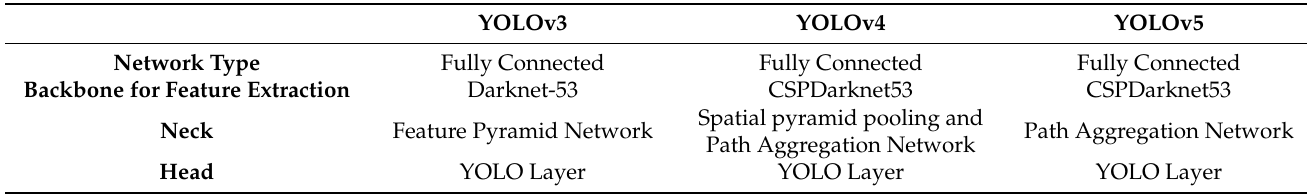
Table 1. Comparison between Different YOLO Architectures